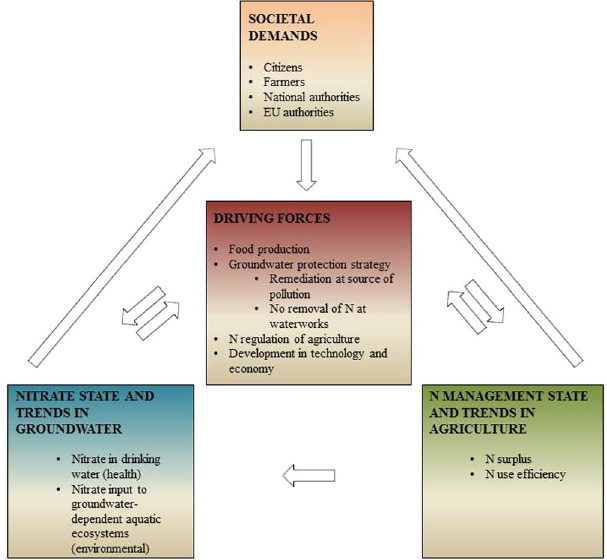
Figure 1. Schematic of the relationship between nitrate response in ground water, sustainable N management in agriculture and major societal demands and driving forces, as inspired by the case of